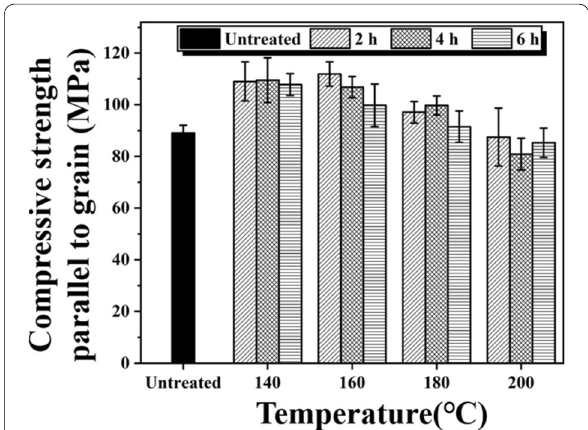
Fig. 7 The compressive strength parallel to grain of untreated sample and the treated samples at varied temperature (140, 160, 180 and 200 °C) for varied time (2, 4 and 6 h)